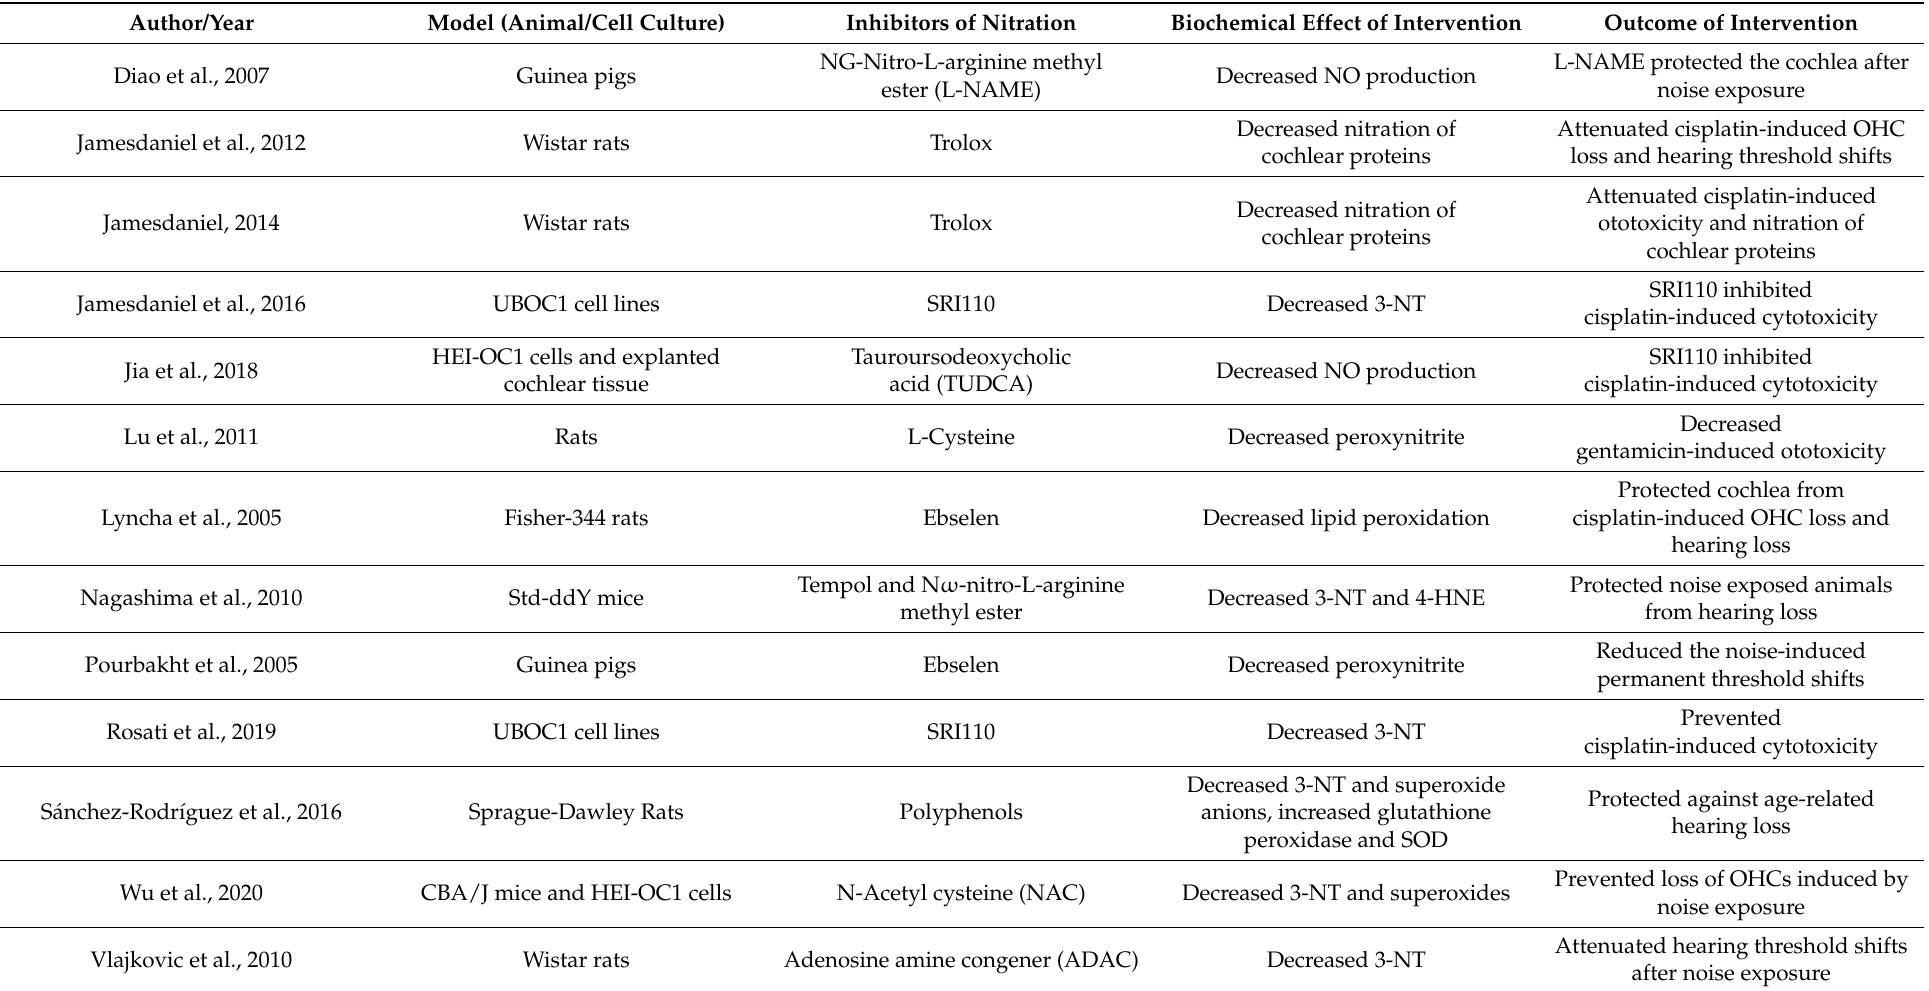
Table 2. Studies showing inhibition of nitration and attenuated hearing loss and auditory